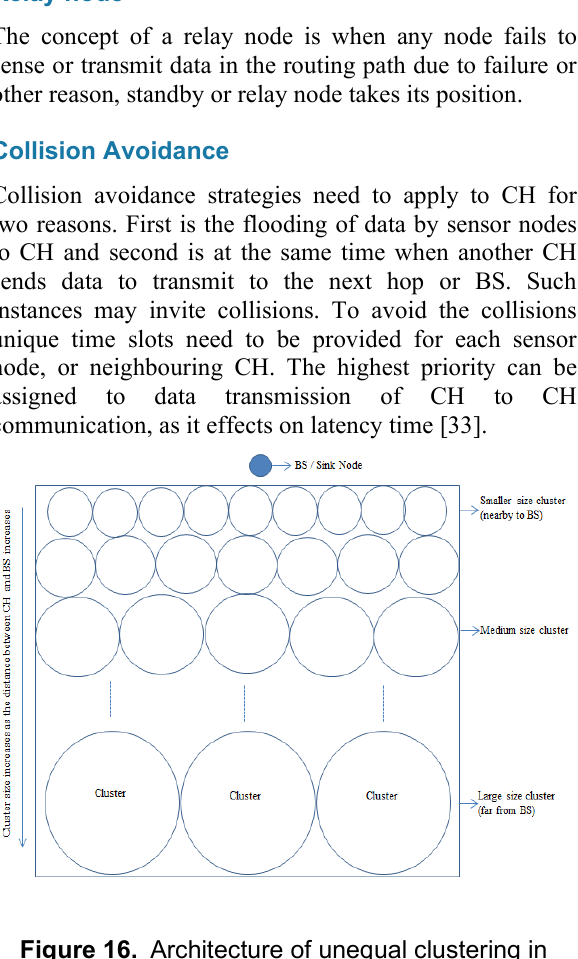
Figure 15. Types of Base station